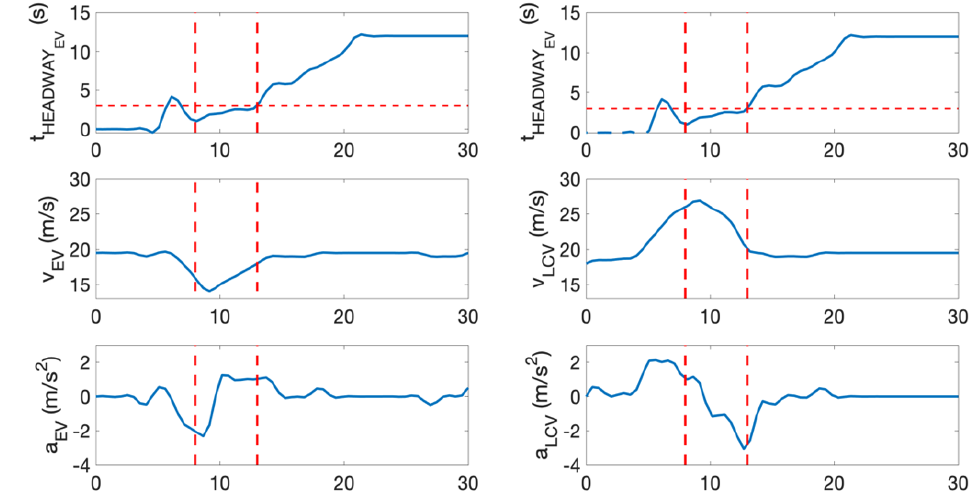
Figure 16. Time headway of ego-vehicle, velocity, and acceleration of ego-vehicle and opponent vehicle.